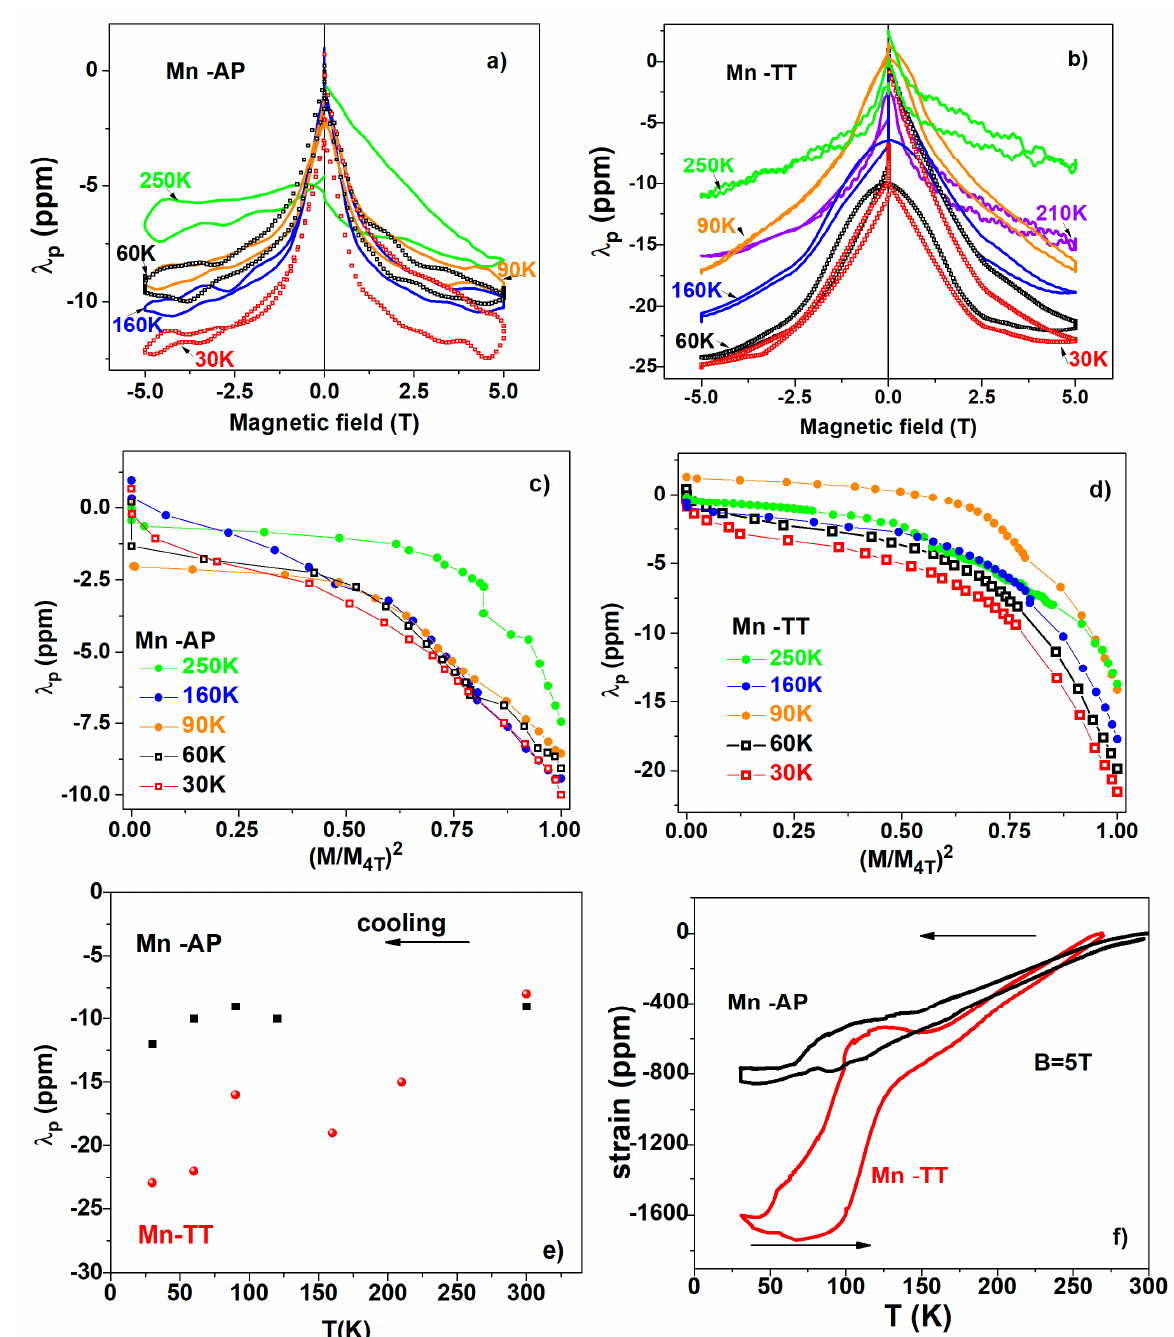
Figure 5. ( a ) Isothermal magnetostriction measurements performed at different temperatures in magnetic fields up to 5 T, applied parallel to the measuring direction for Mn-AP; ( b ) the same for Mn-TT ribbons; ( c ) the parallel magnetostriction plotted versus the square of (M/M4 T) for Mn-AP; ( d ) the same for Mn-TT ribbons; ( e ) the temperature dependence of parallel magnetostriction ( λ p); ( f ) thermo-strain dependencies recorded in 5 T.